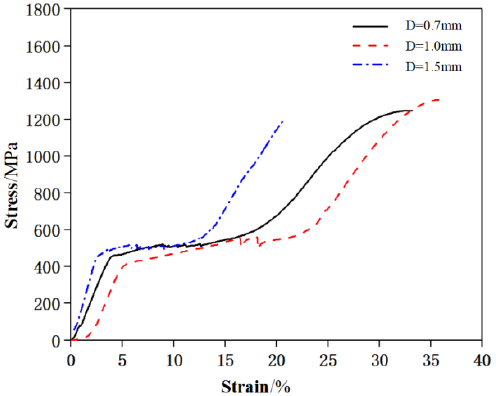
Figure 3. Direct tensile stress-strain curve of SMA wires. Table 2. Uniaxial tensile mechanical properties of SMA